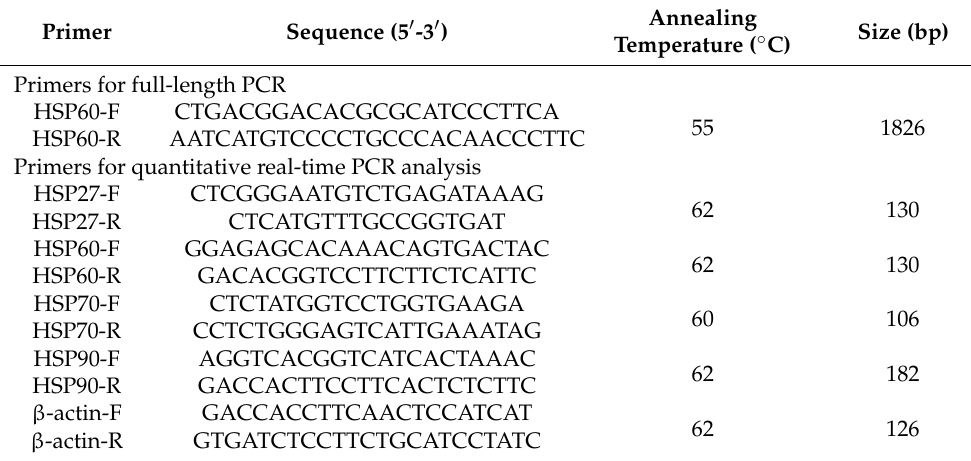
Table 1. Primer sequences used in this